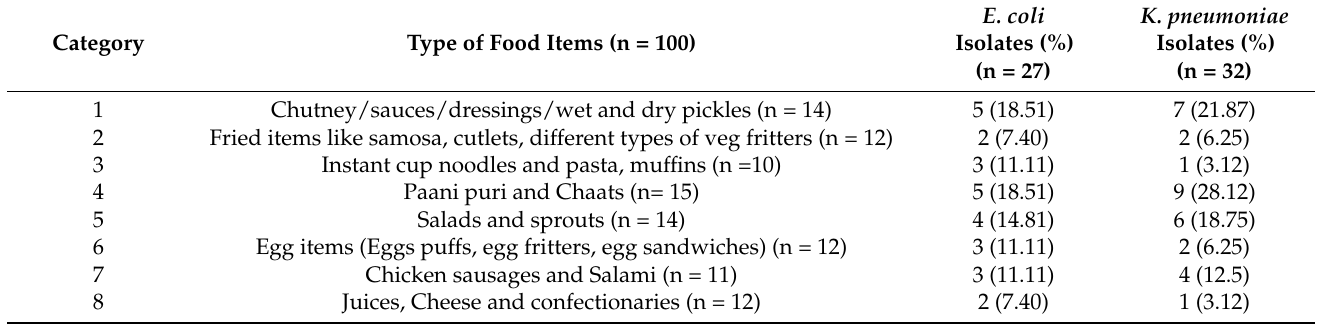
Table 2. Escherichia coli and Klebsiella pneumoniae isolates from each category.